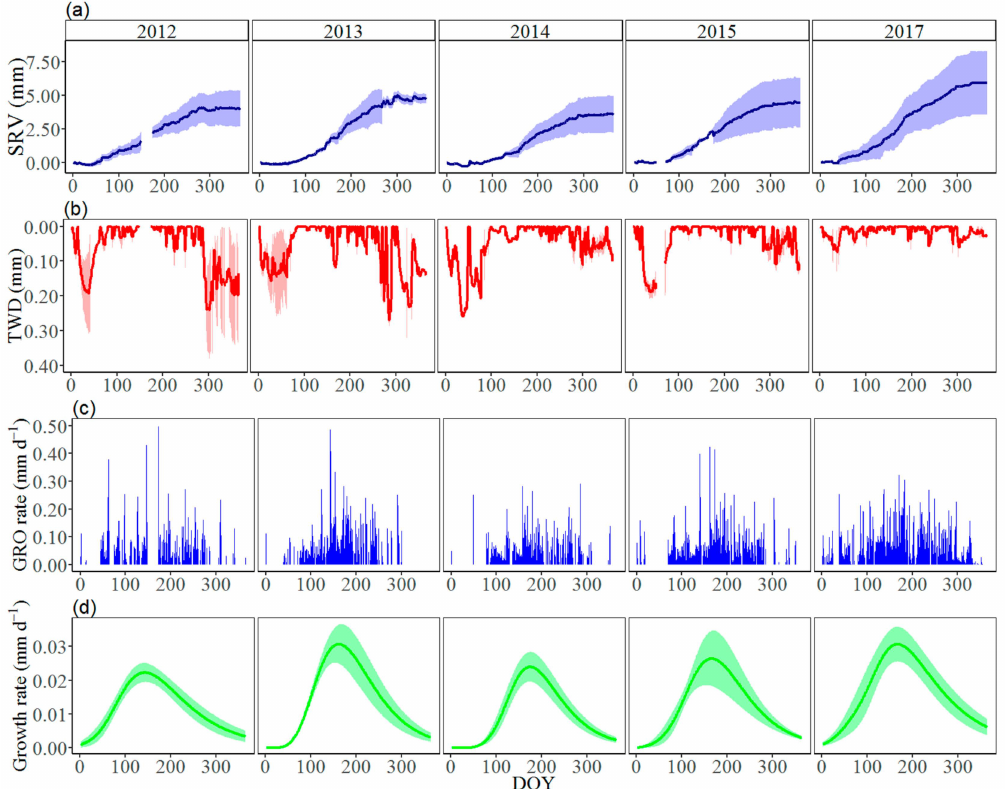
Figure 2. ( a ) Cumulative daily mean stem radius variations (SRV, mm); ( b ) daily minimum tree water deficit (TWD); ( c ) daily sums of growth-induced irreversible stem expansion (GRO rate) calculated from a zero-growth (ZG) model ([8]); ( d ) daily stem growth rates of Pinus kesiya var. langbianensis trees modeled with a Gompertz function for the years 2012–2015 and 2017. Shaded areas indicate the standard error of the